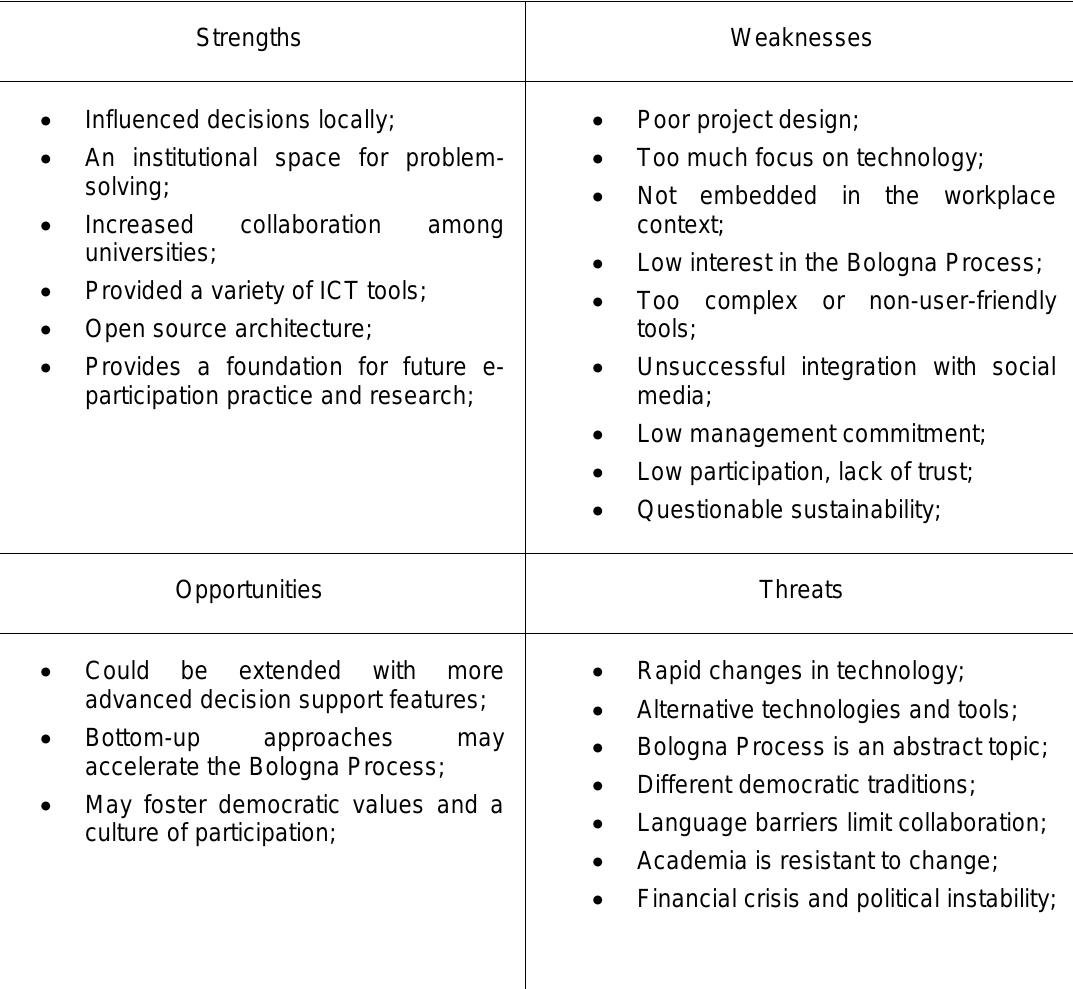
Table 2: SWOT analysis of MyUniversity Strengths